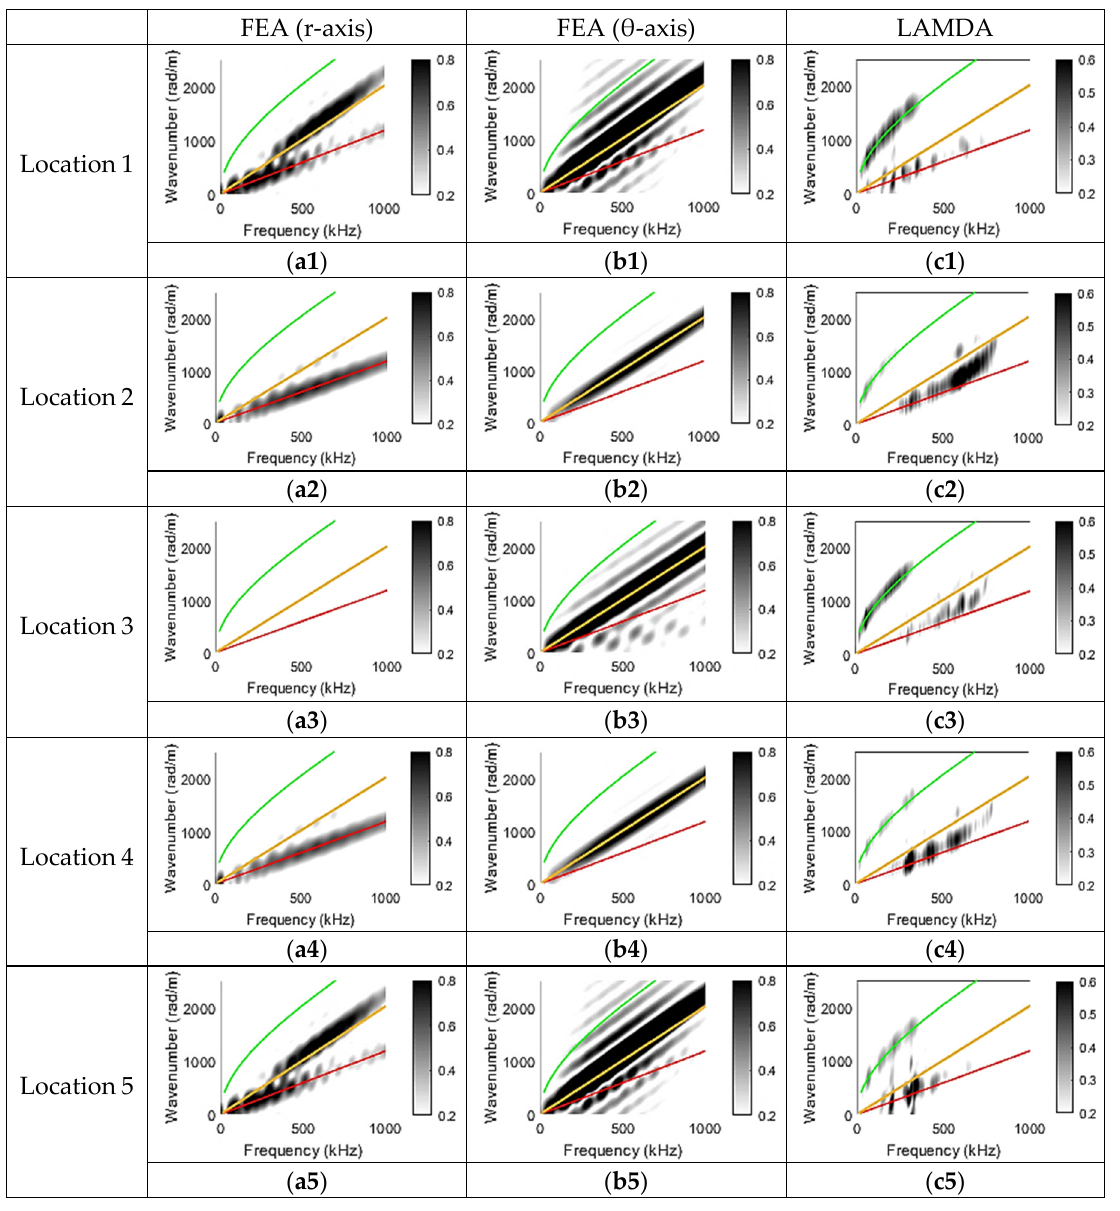
Figure 8. Longitudinal PLB results. Top row shows wavenumber–frequency plots corresponding to the radial component obtained from FEA, the angular component obtained from FEA, and from the LAMDA sensor at location 1. Second row as for top row but for location 2. Third row as for top row but for location 3. Fourth row as for top row but for location 4. Bottom row as for top row but for location 5.